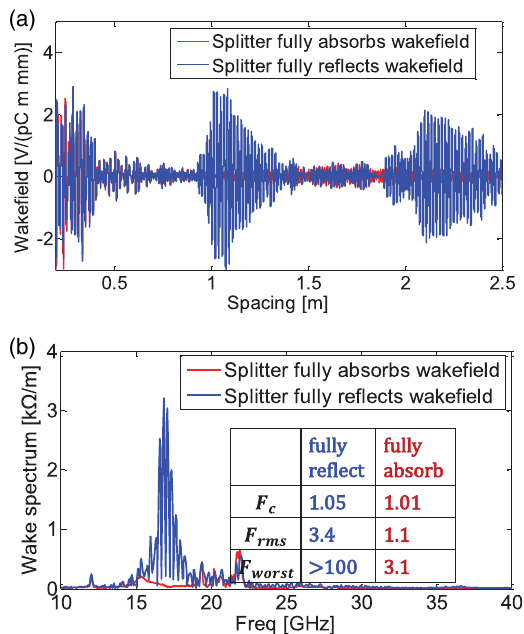
FIG. 25. Transverse wakefield of new CLIC accelerating structure with splitter absorbing or reflecting the dipolar wake- field: (a) time domain (please note the horizontal scale starts not from 0); (b)